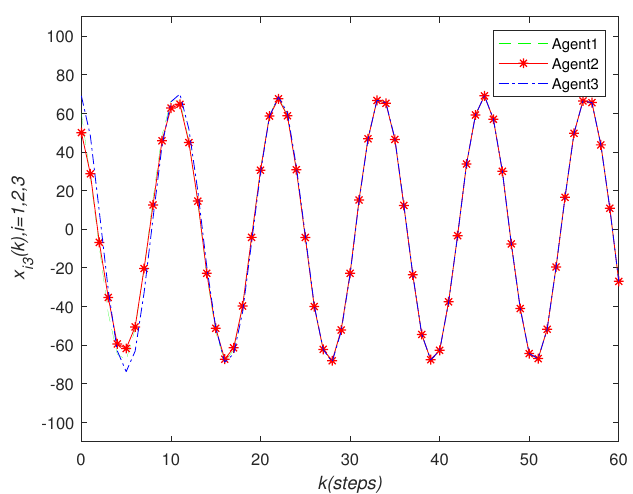
Figure 5. State trajectories x i 2 ( k ) of agent i .